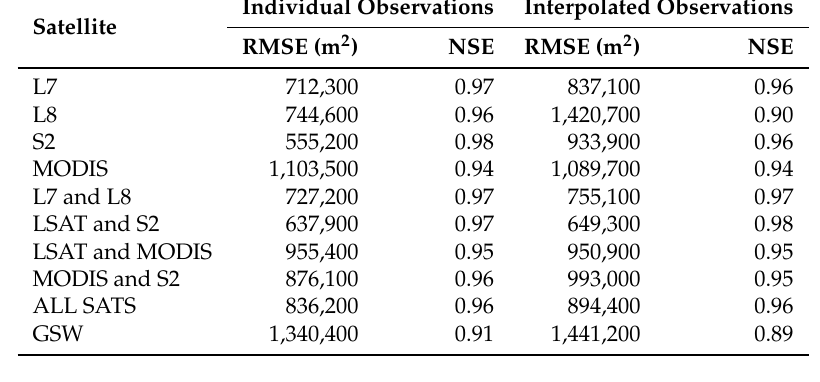
Table 7. RMSE and NSE between remotely sensed flooded areas and ground truth data and daily interpolated areas from each sensor and multi-sensor combinations (2015–2019).